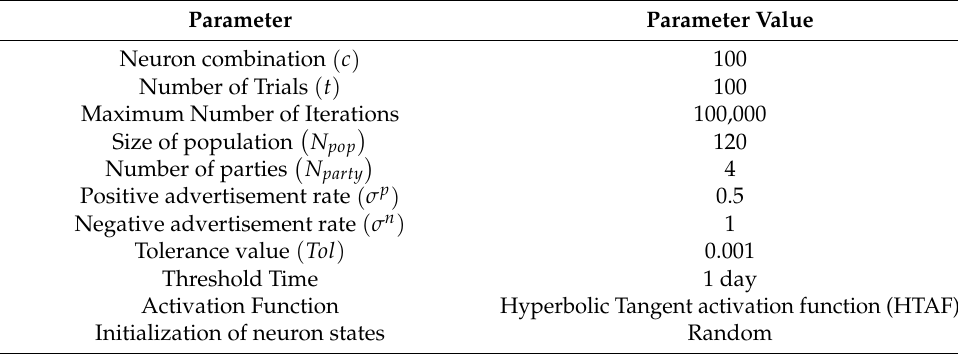
Table 1. List of parameters utilized in HNN-RAN3SATEA